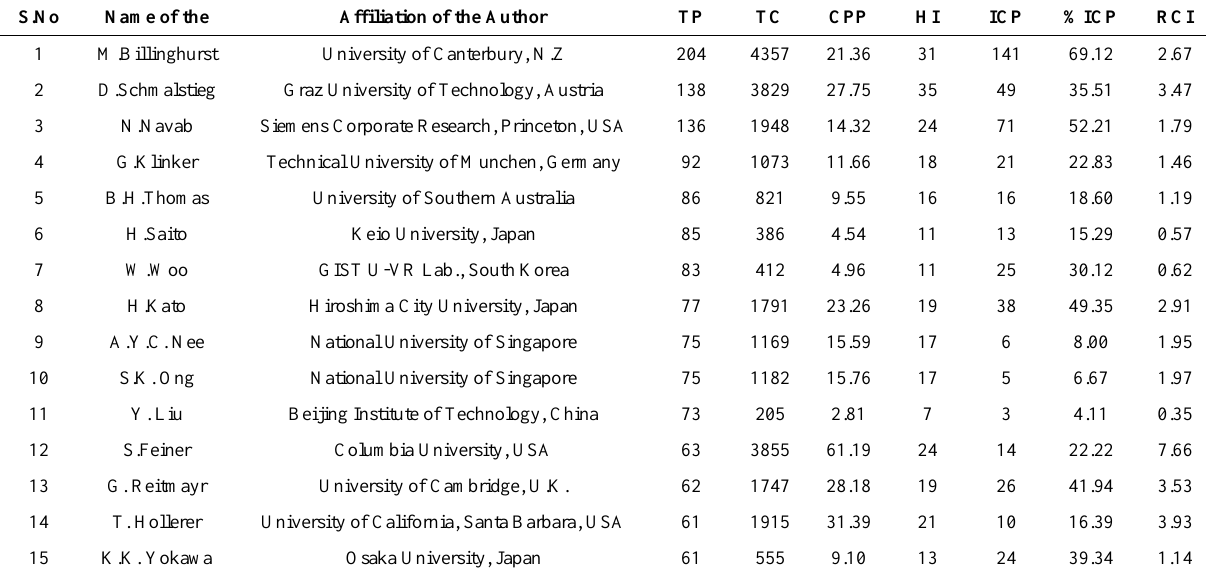
Table 6. Scientometric profile of top 15 authors in deep learning research in citation per paper and relative citation